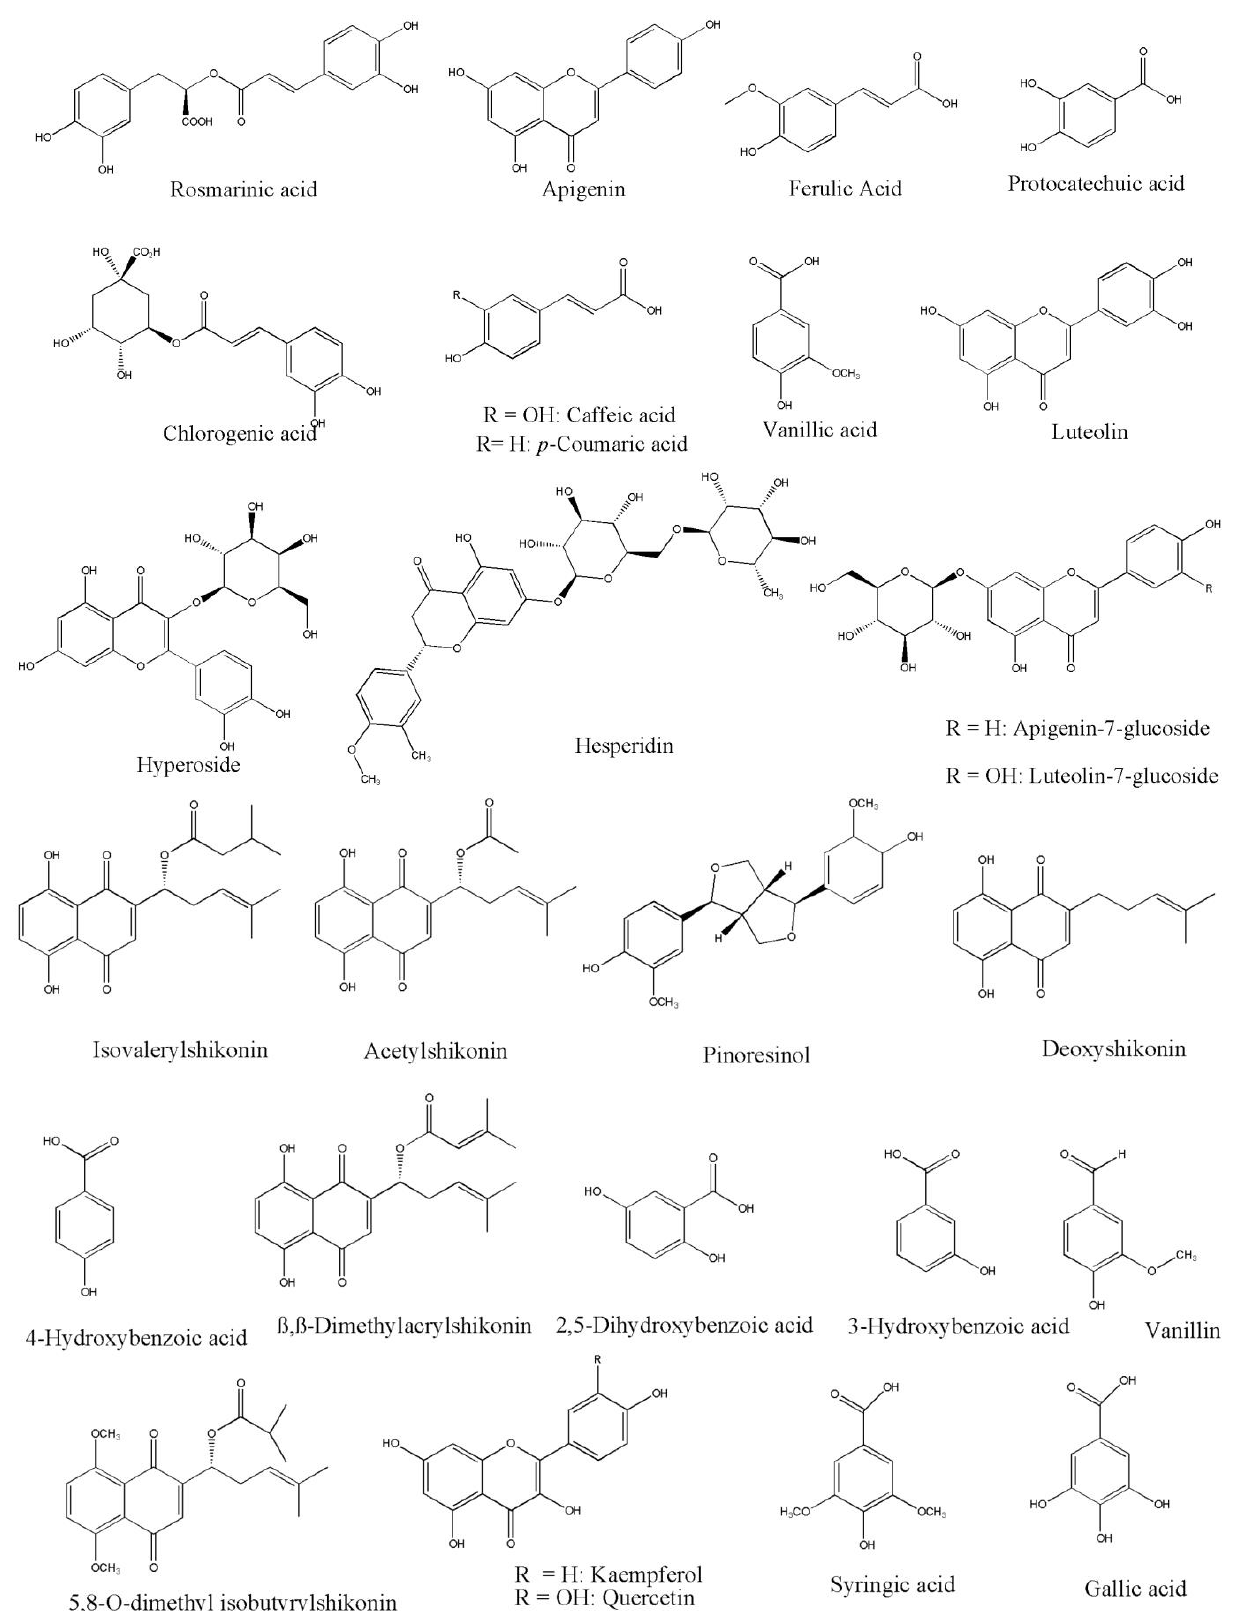
Figure 6. Representative of main compounds isolated from Onosma species, repeated in the literature.